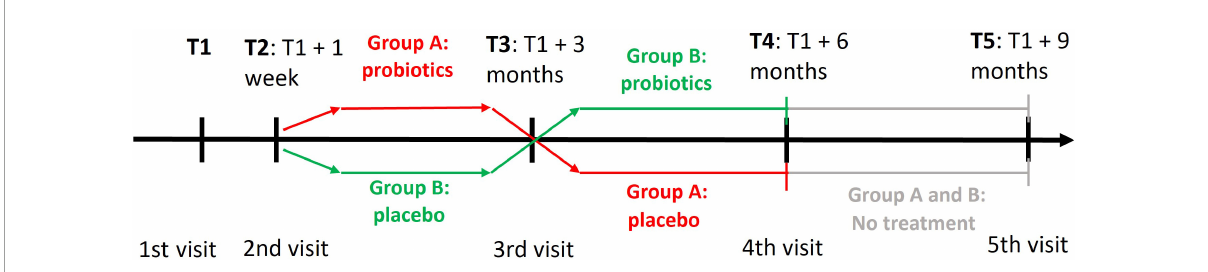
FIGURE2 A cross-over design of the clinical trial with probiotics. T1 denotes the time of first visit when participants were assessed with the PROCOG cognitive battery. The two groups received both probiotic and placebo tablets but in a reverse order. At T2 the participants brought back baseline urine and stool samples and their blood was collected. They also got the first set of probiotic/placebo tablets. All examinations and procedures from T1 and T2 were repeated at T3 when the participants got the second set of probiotic/placebo tablets. All examinations and procedures similar to T3 were repeated at T4 and